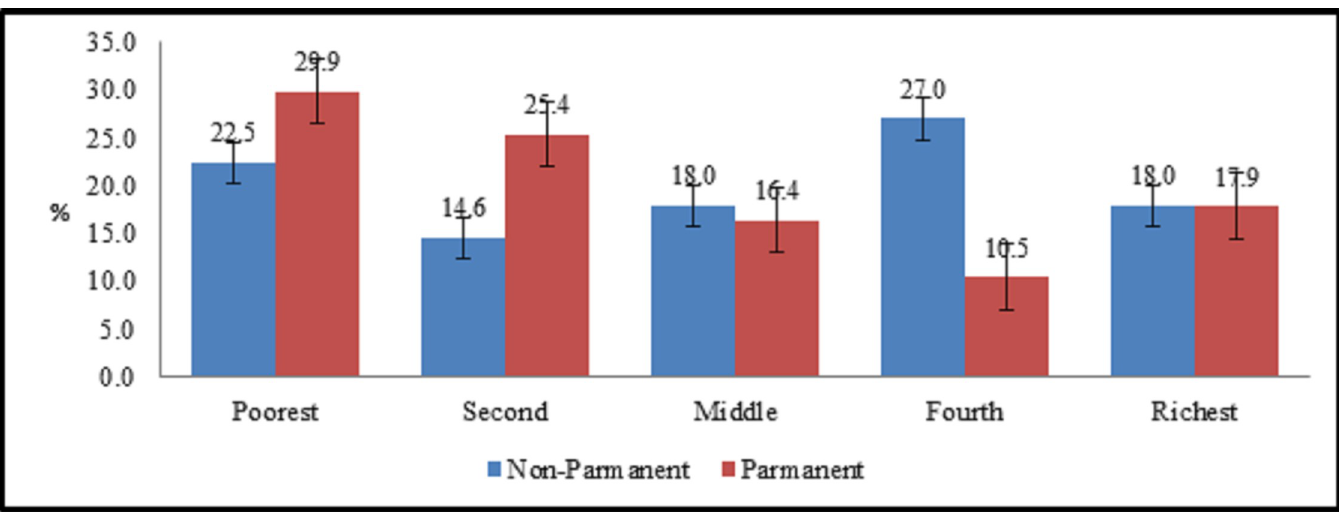
Fig 3. Job status and socioeconomic.